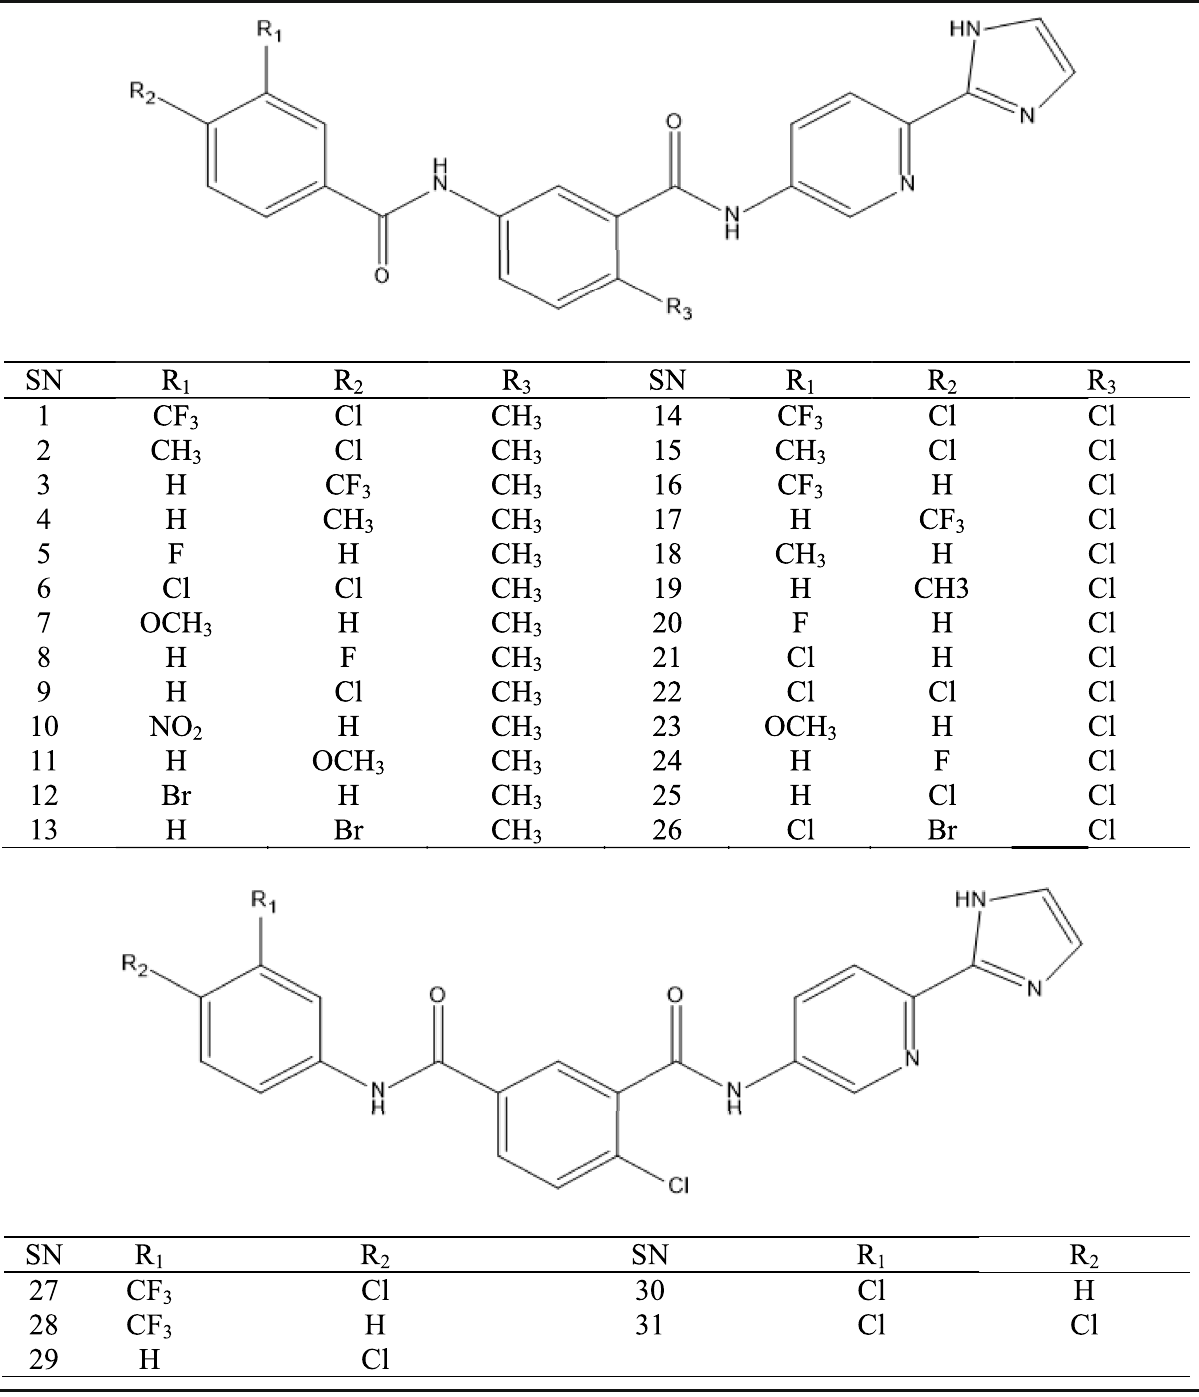
Table 1 Chemical structures of the studied